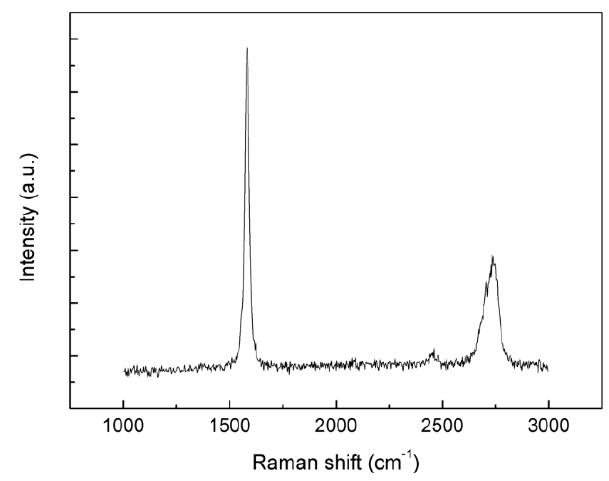
Figure 3. Raman spectra of the prepared GN.